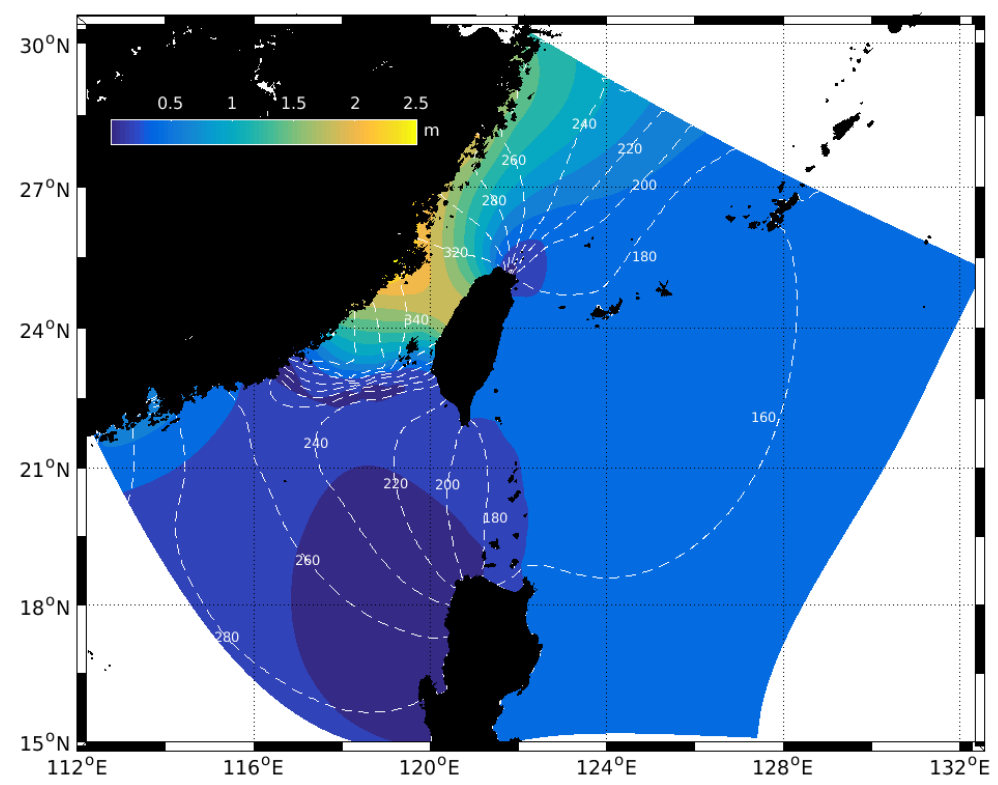
Figure 5. The co-tide chart for the M2 tide based on the output of the ROMS model forced only by tides. Dashed lines denote phase while shading colours represent amplitude.